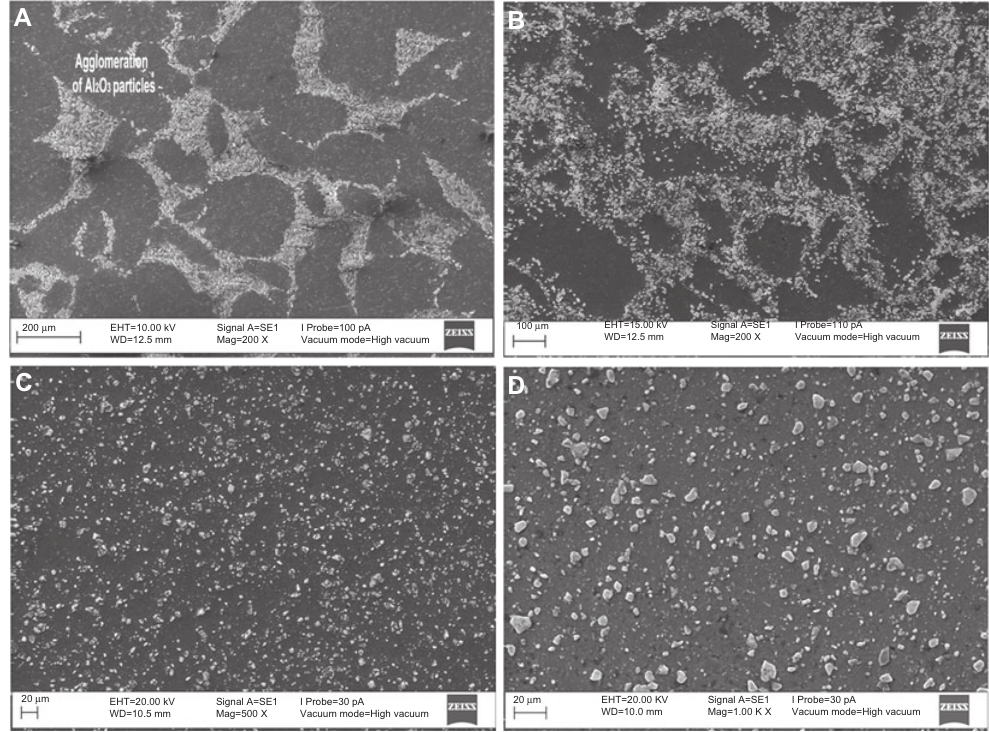
Figure 12 Distribution of Al (D) 7